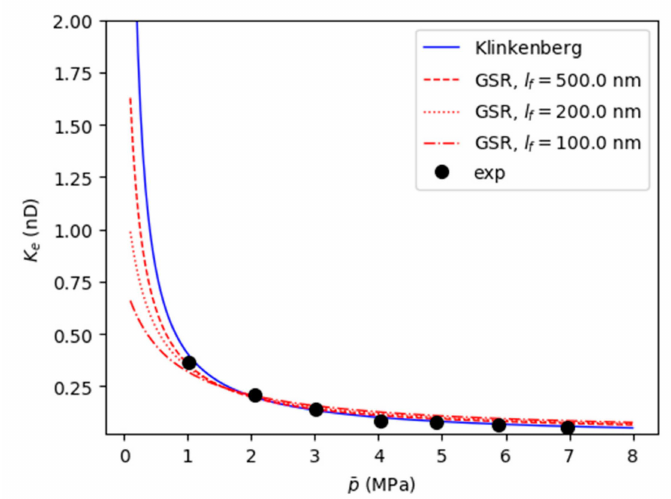
Figure 13. A comparison of the permeability fitting using the general slip regime (GSR) model and the Klinkenberg model. The characteristic flow scales l f used for the fitting with the GSR model were 100, 200, and 500